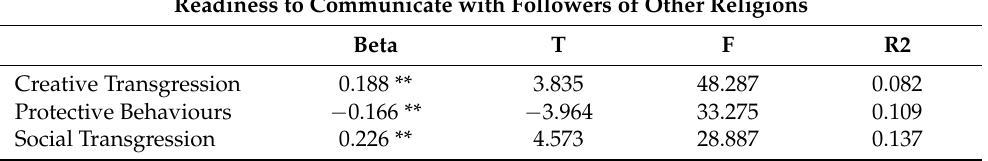
Table 4. Regression analysis of the Transgression dimensions which explain Readiness to Communi- cate with Followers of Other Religions (N =